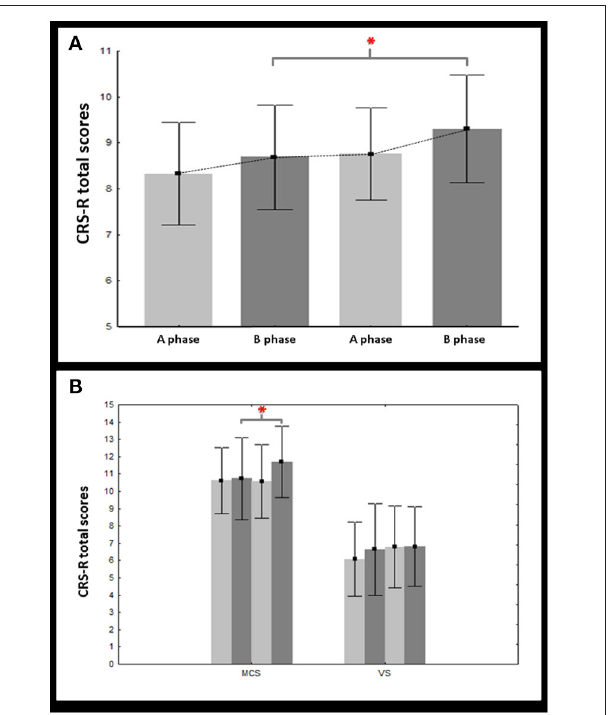
FIGURE 1 | Changes in CRS-R total scores. This figure illustrates the mean (bars = 95% confidence intervals) of the CRS-R total scores on treatment (dark gray) vs. off treatment (light gray) for both vegetative (VS) and minimally conscious (MCS) groups (A) but also within each group, separately (B) . Asterisks indicate significant results ( p < 0.05).